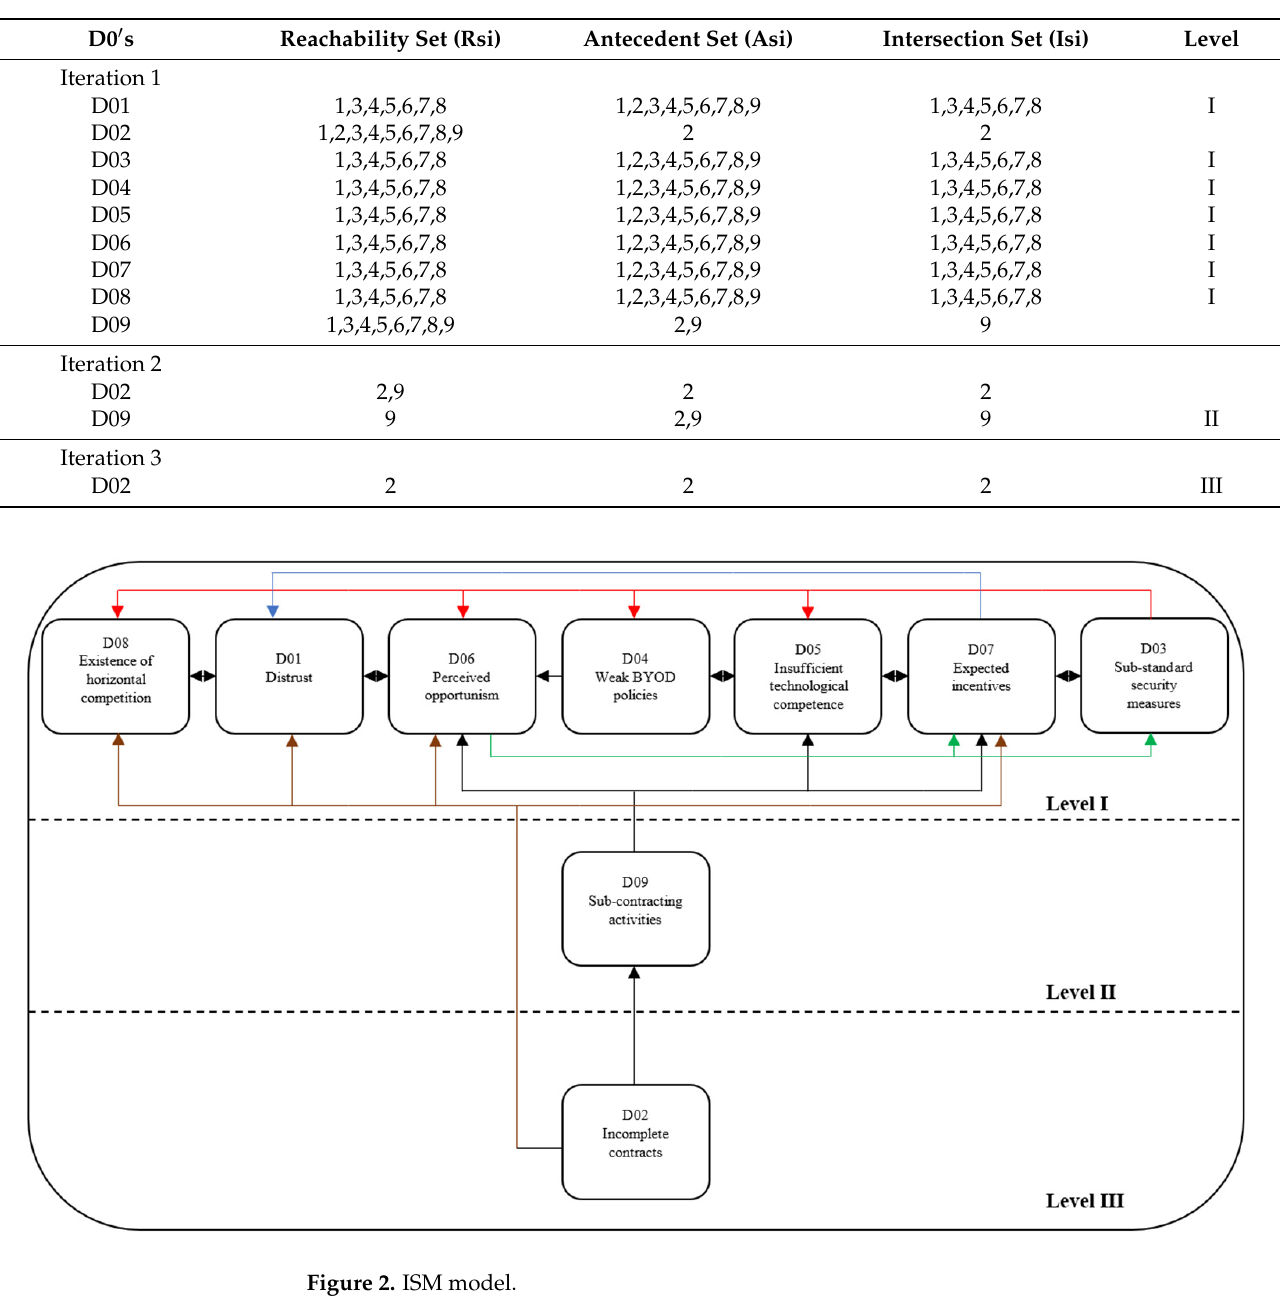
Table 5. Level partition for the drivers.